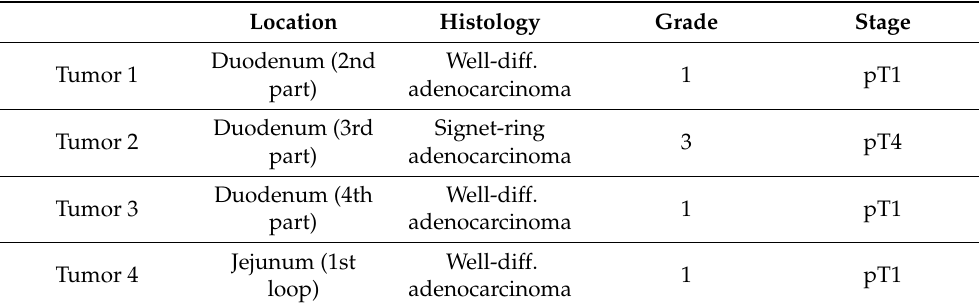
Table 1. Tumor location and main histological